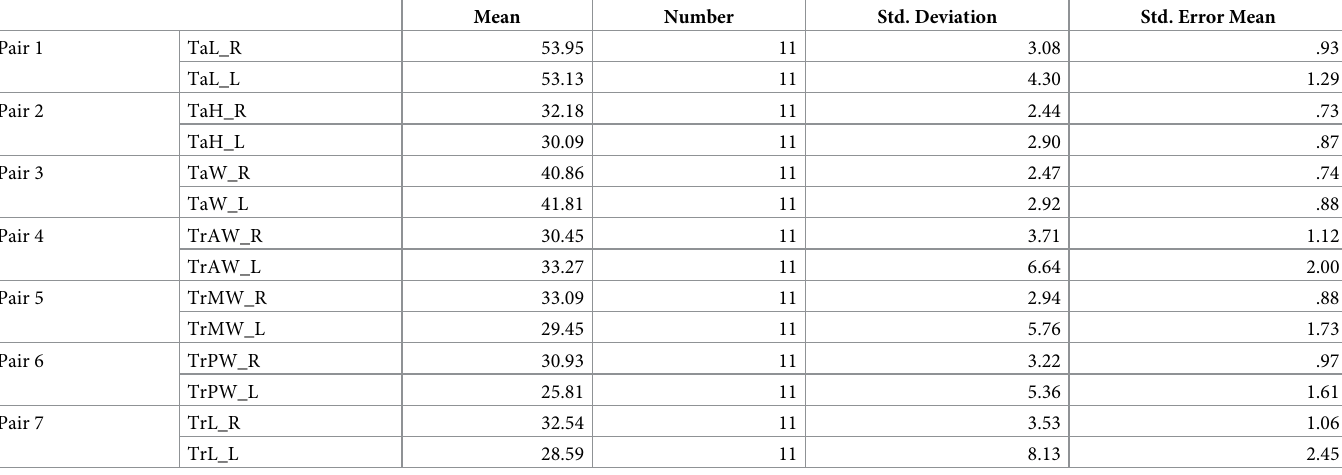
Table 1. The morphometric profiles of talus from 11 matched pairs of tali. Mean Number Std. Deviation Std. Error Mean